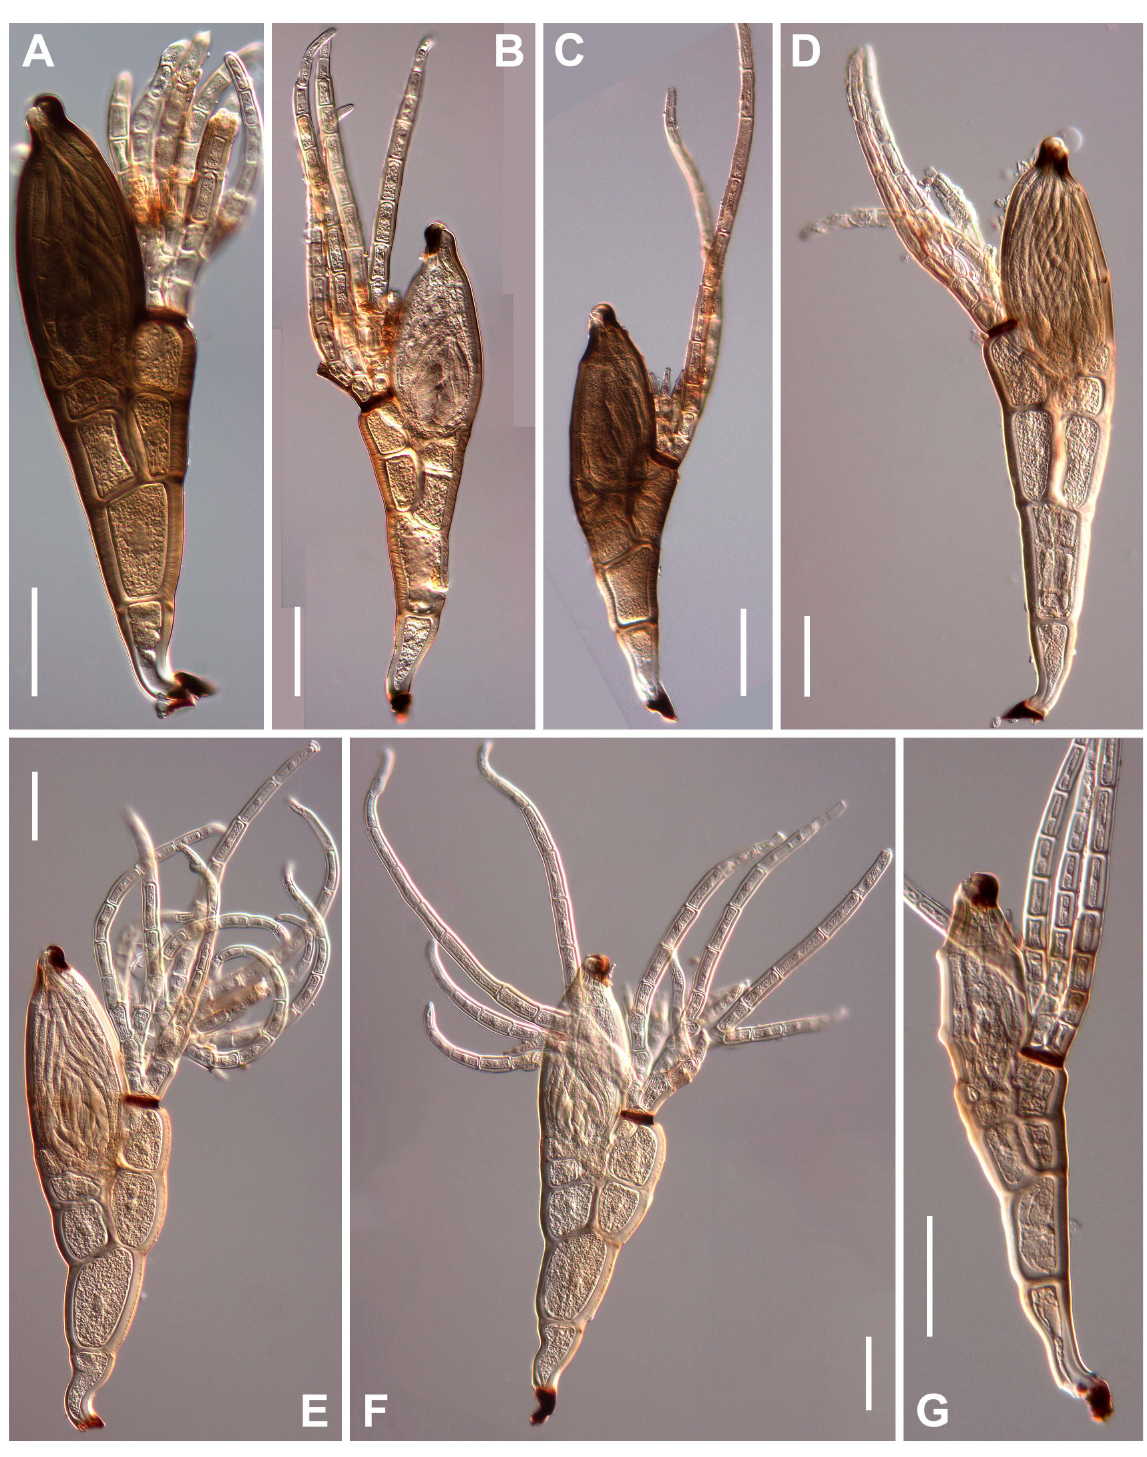
Fig. 32. A – G . Laboulbenia flagellata Peyr. Mature thalli from Agonum fuliginosum (A), Agonum muelleri (B), Loricera pilicornis (C), Anisodactylus binotatus (D), Platynus assimilis (E–F), and Anchomenus dorsalis (G). Scale bars: 50 µm. Photographs from slides ZMUC C-F-122491 (A), ZMUC C-F-122590 (B), ZMUC C-F-123321 (C), ZMUC C-F-122589 (D), ZMUC C-F-122578 (E–F), ZMUC C-F-122829